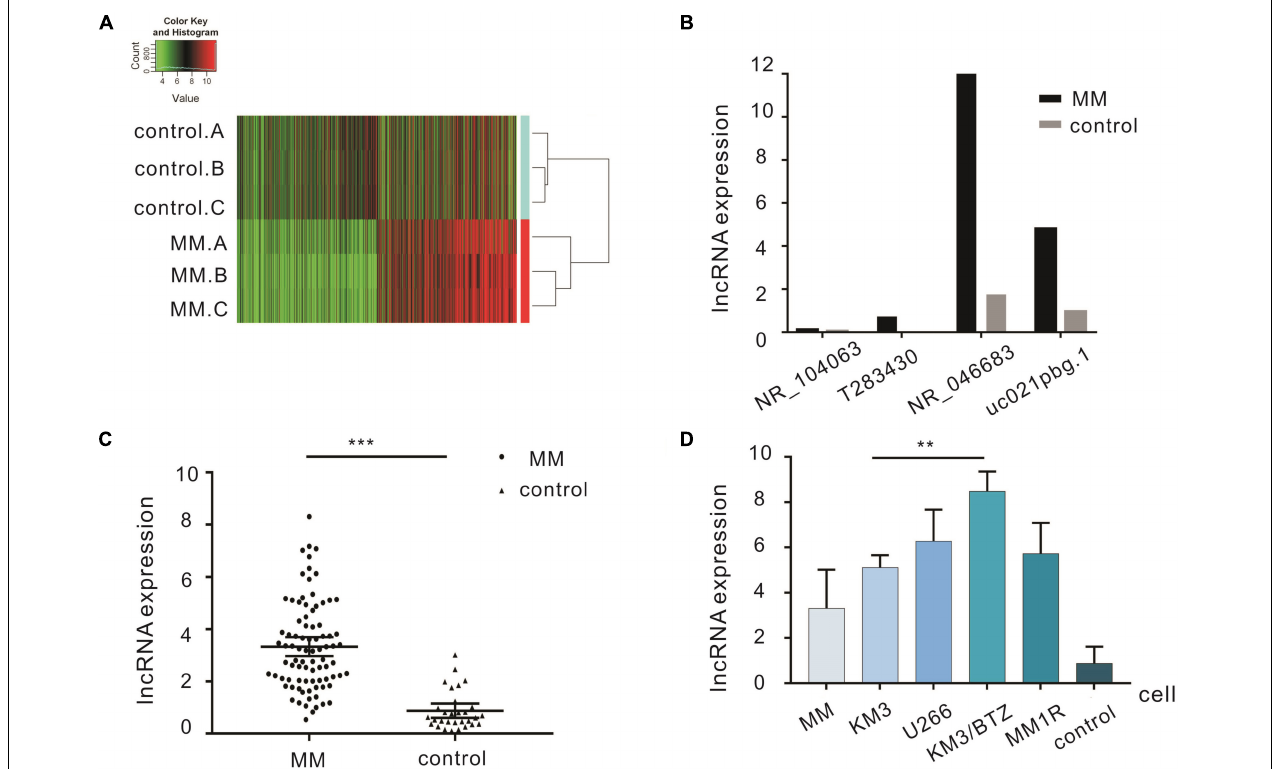
FIGURE 1 | Differentially expressed lncRNAs in the bone marrow of MM patients. (A) Cluster analysis diagram of differentially expressed lncRNAs. (B) qRT-PCR verification of four lncRNAs in MM patients and controls. (C) Expression of lncRNA NR_046683 in the bone marrow of 86 MM patients and 30 controls. (D) Expression of lncRNA NR_046683 in MM patients,KM3 cell line, U266 cell line, KM3/BTZ cell line, MM1R cell line and controls. ∗∗ p < 0.005; ∗∗∗ p < 0.0001. MM, multiple myeloma; qRT-PCR, Real-time quantitative polymerase chain reaction.